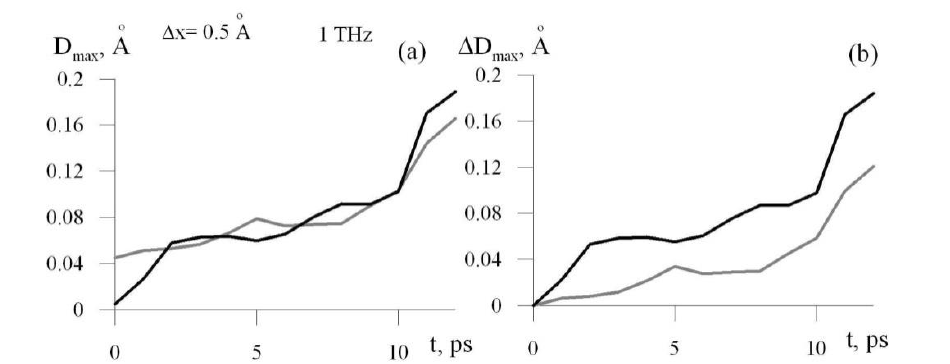
Fig. 15. Maximal dispersion of atomic planes versus time (а) and variations of the maximal dispersion in respect to the same value in the undisturbed system (b). Black line – perfect crystal, grey line – amorphized system.  x 0 = 0.5 Å,  =1 THz.